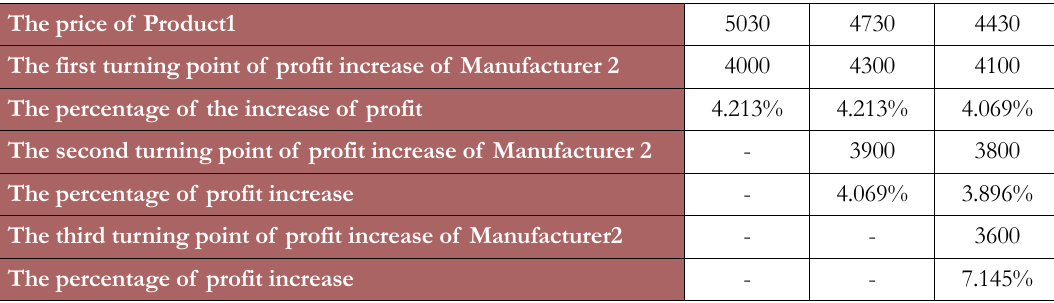
Table 6. The situation of Manufacturer2’s profit change with the Lenovo and HP computer prices